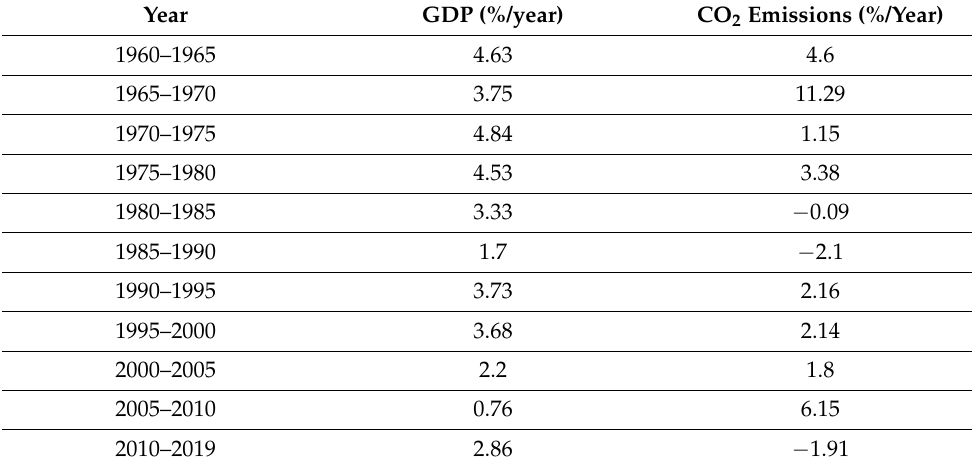
Table 2. Annual changes in Norway’s CO 2 emissions and changes in GDP: 1960–2019. Average annual growth rates in %. Source: Statistics Norway